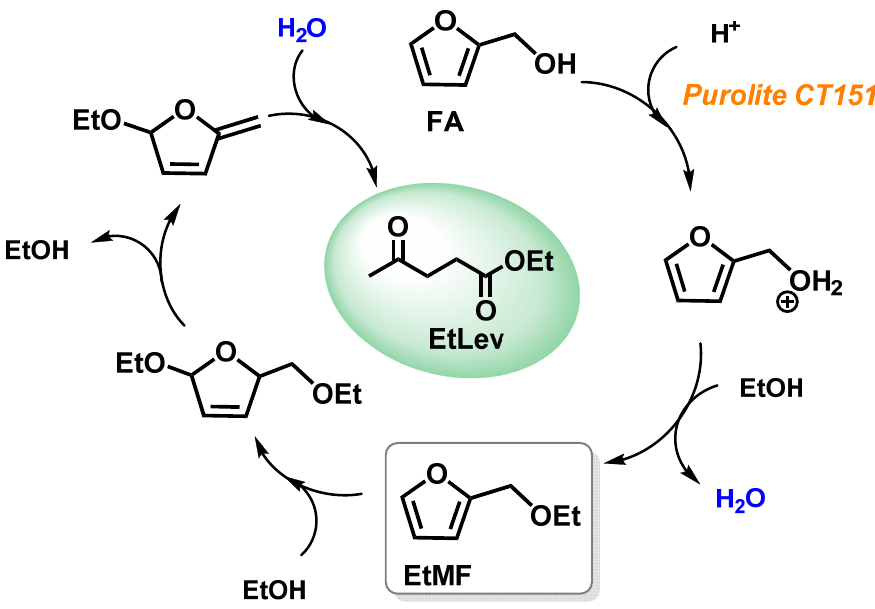
Figure 3. Proposed reaction mechanism for the alcoholysis of FA.